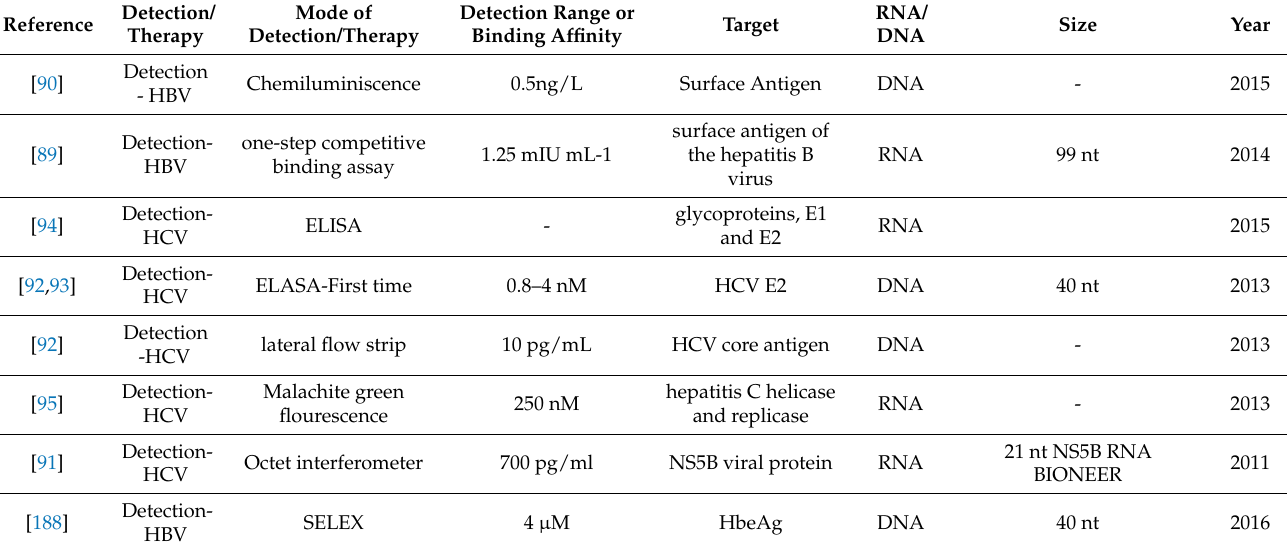
Table A2. List of aptamers and their properties for treatment and detection of Hepatitis B, C and D virus